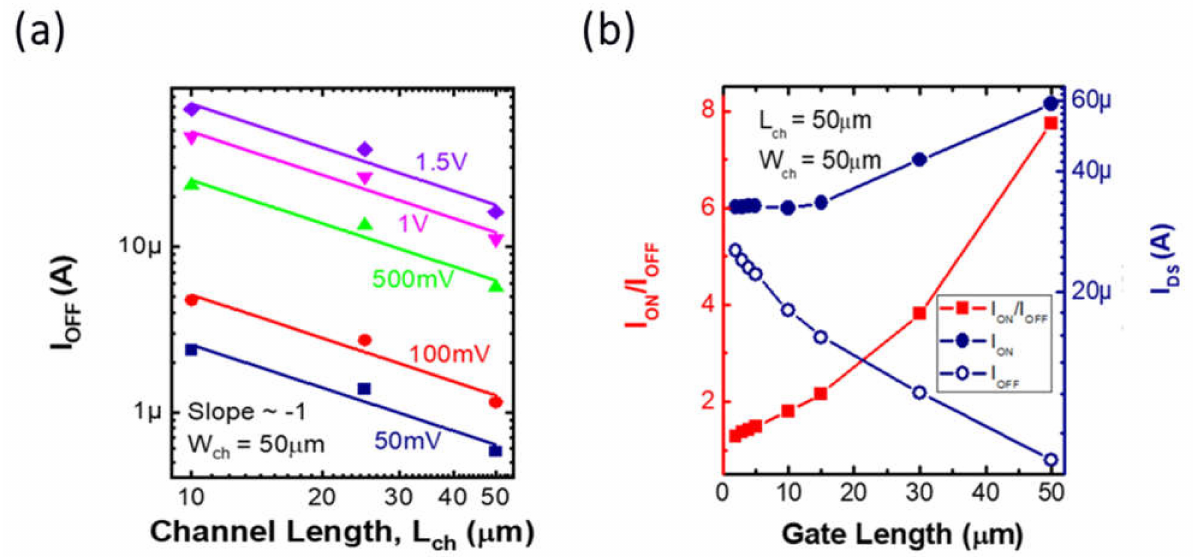
Figure 6. ( a ) I OFF dependence on channel length for 25 nm InAs grown directly on glass, with V DS values next to corresponding line (V GS = − 5 V). ( b ) I ON , I OFF , and I ON /I OFF vs. gate length for the same sample (V DS = 1 V, I ON V GS = 5 V, I OFF V GS = − 5 V), shown in Figure